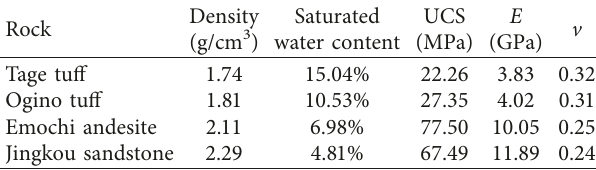
Table 1: Physicomechanical properties of the specimens. Rock